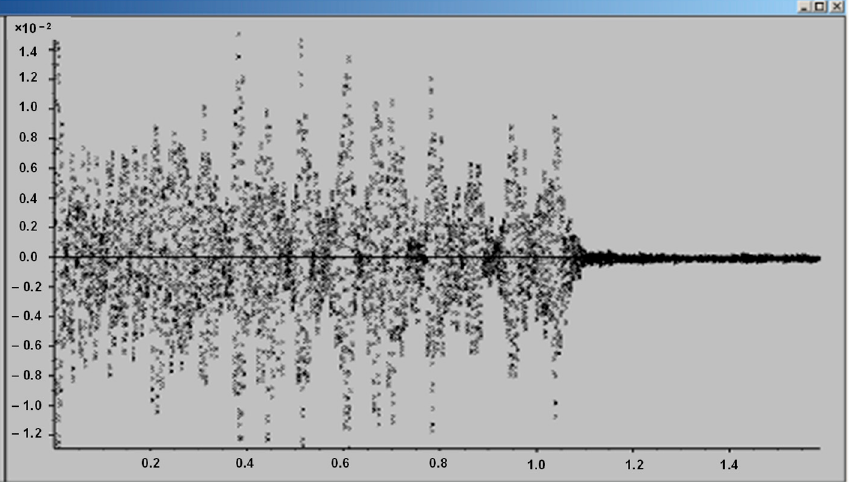
Figure 14. Data after nonelectric detonator vibration test and transition.